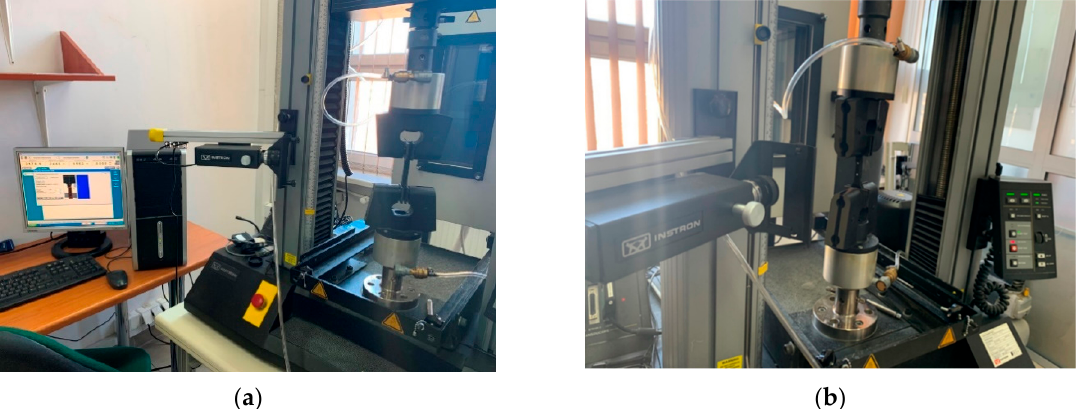
Figure 6. Tensile test of the elastomeric materials: ( a ) test stand; ( b ) sample with visible marks and video extensometer before the test.